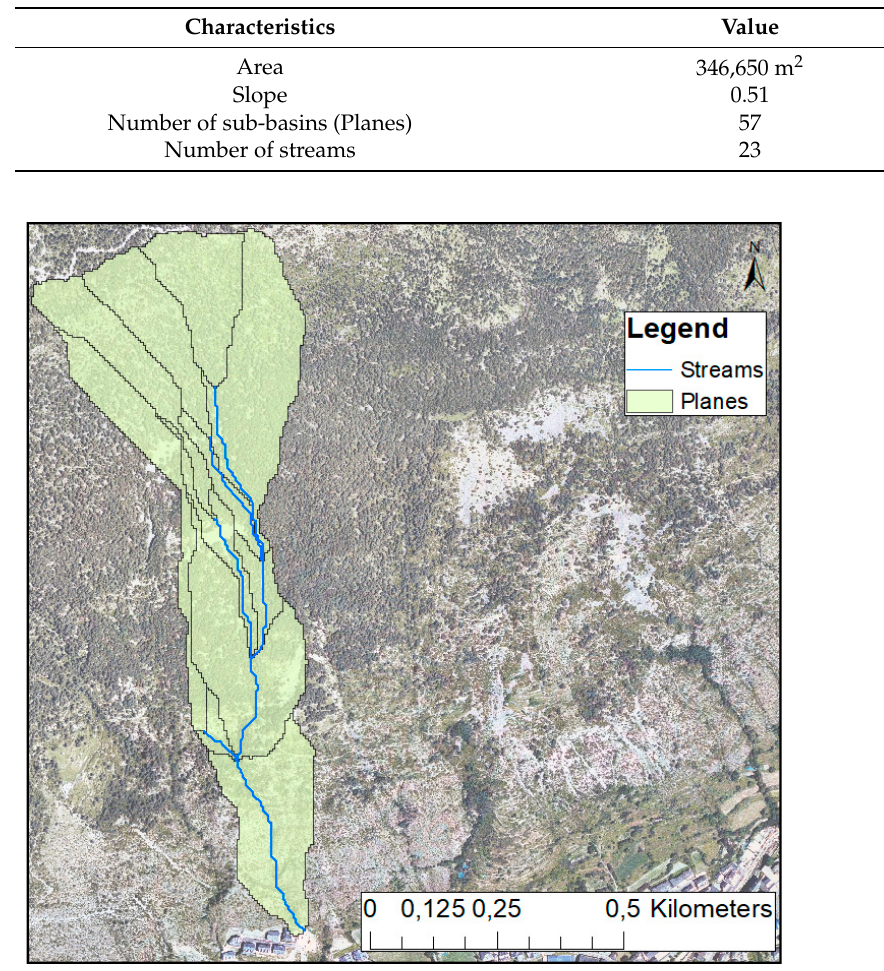
Figure 4. Generated basin with sub-catchments and streams. Table 3. Detail value of study basin [3].